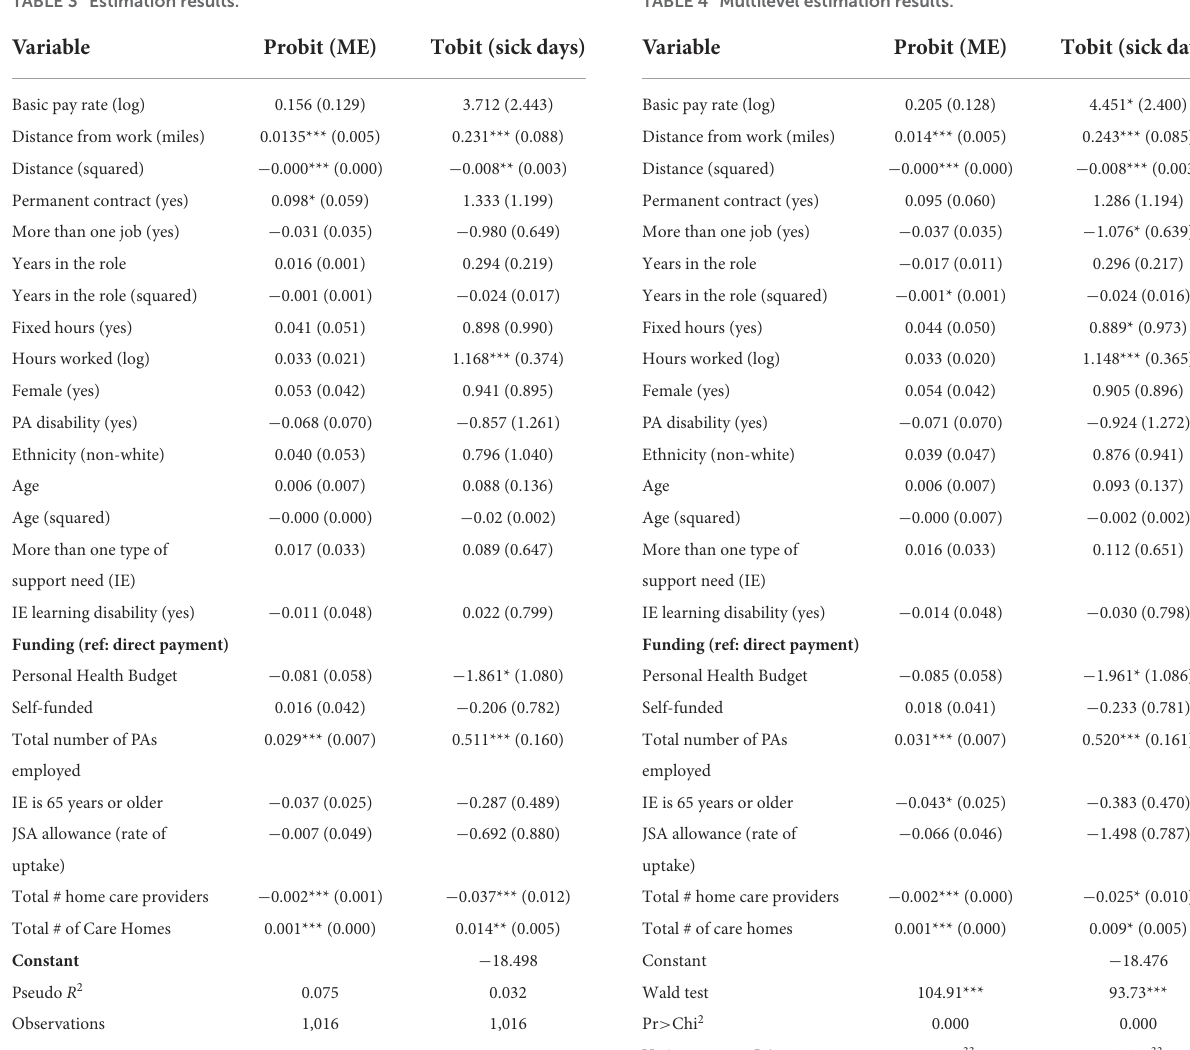
TABLE 3 Estimation results. TABLE 4 Multilevel estimation